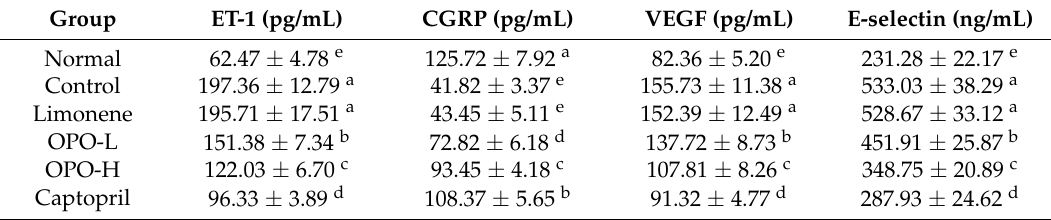
Table 5. Serum levels of ET-1 (endothelin-1), CGRP (calcium gene-related peptide), VEGF (vascular endothelial growth factor) and E-selectin in L -NNA-induced hypertensive rats.